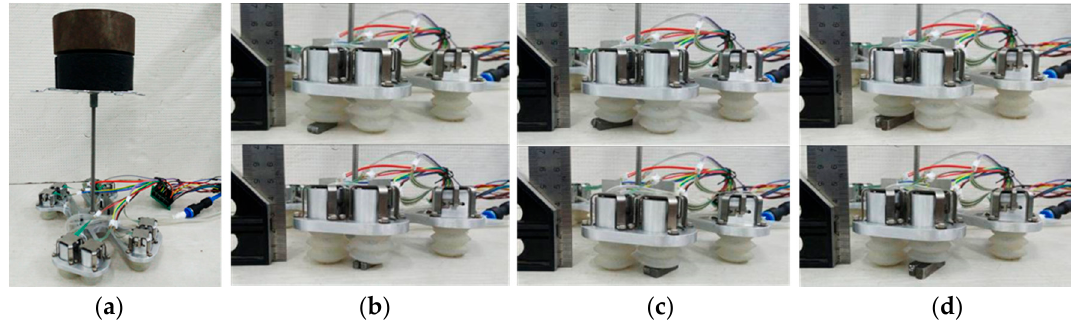
Figure 11. The experiment on the foot system. ( a ) The overall experimental apparatus; ( b ) the foot on a 3-mm high bump; ( c ) the foot on a 5-mm high bump; and ( d ) the foot on an 8-mm high bump.